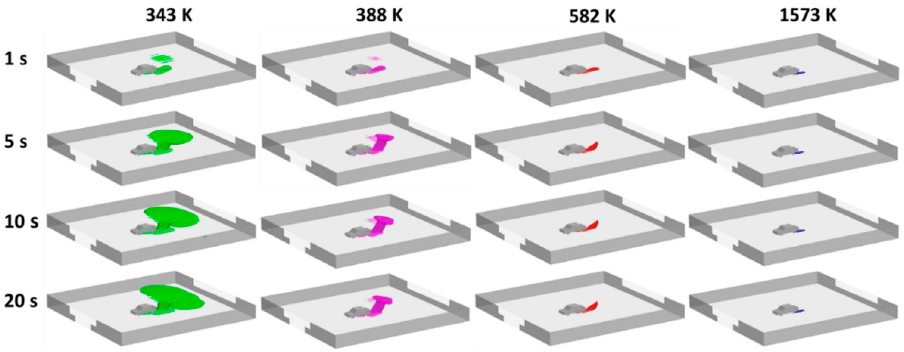
Figure 18. Iso-surfaces showing no-harm (343 K), pain (388 K) and fatality (582 K) limits and visible flame temperature (1573 K) for ignited hydrogen release in case 11 (TPRD = 0.5 mm, 45° angle downward release with tank blowdown and car body).